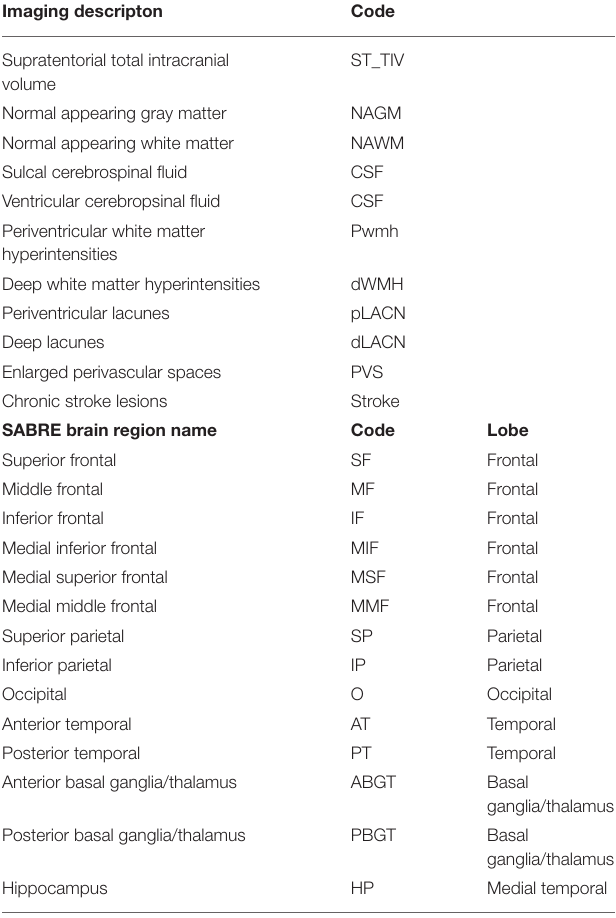
TABLE 1 | SABRE-LE neuroimaging pipeline brain tissue and lesion codes (top), and detailed SABRE brain region codes (bottom). Imaging descripton